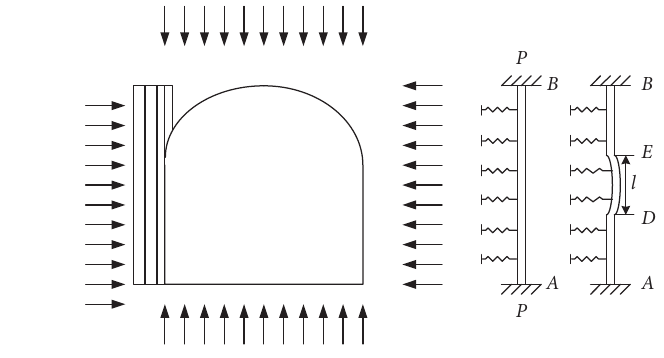
Figure 4: Mechanical model of slab-beam